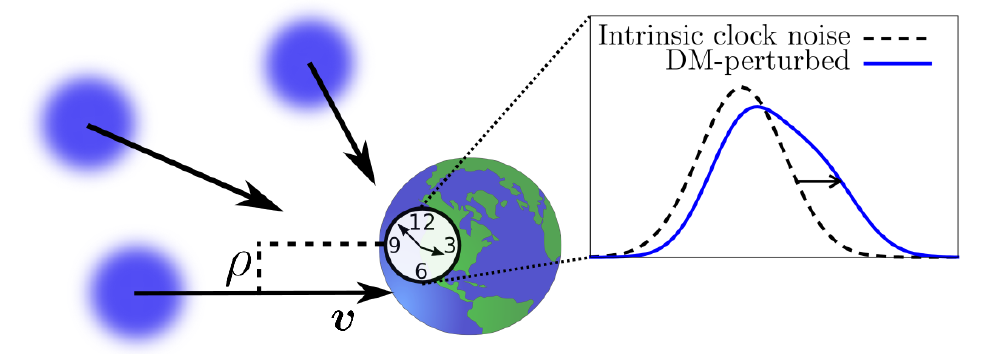
Figure 1. DM objects incident upon the Earth, and the induced shift and asymmetry in the clock noise